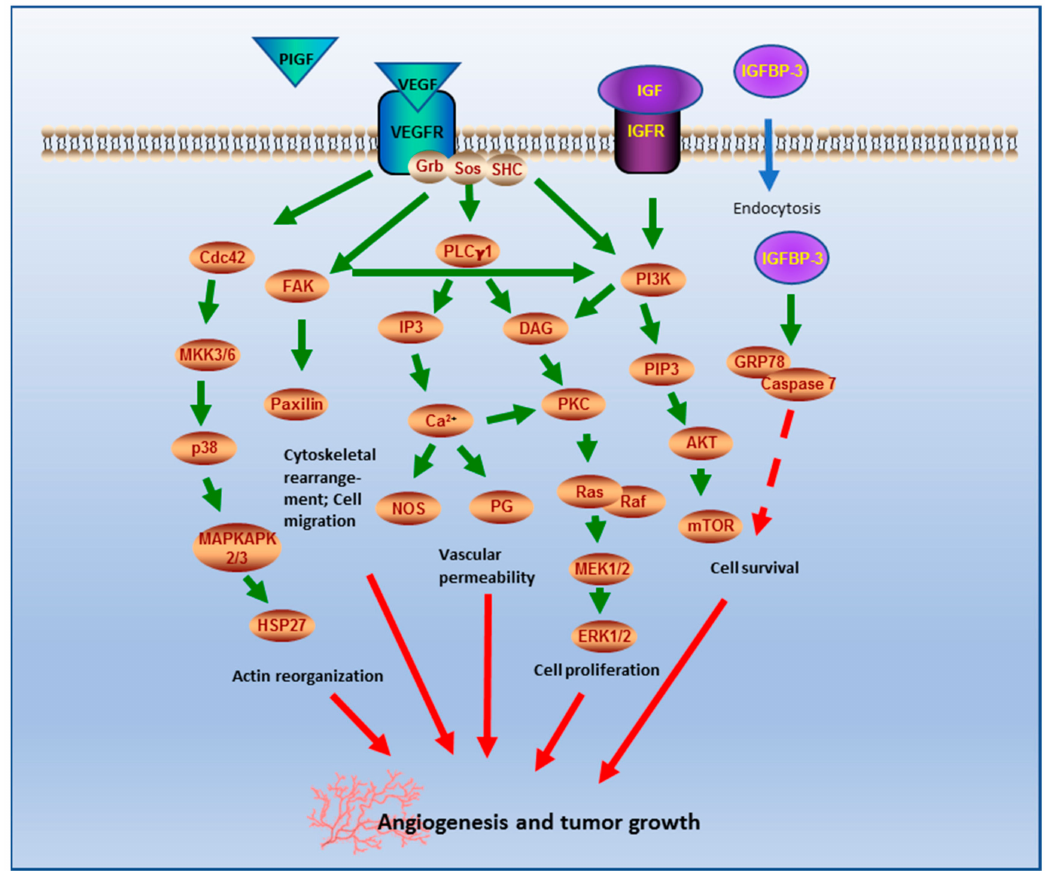
Figure 5. Simplified scheme of putative role, function, and involvement of VEGF, PlGF, and IGFBP-3 in signaling pathways described in angiogenesis and tumor growth. The downstream signaling pathway of the VEGF receptor (VEGFR), including adaptor proteins son of sevenless (SOS), growth receptor bound (Grb) 2, and Src homology 2 domain, can be activated by the ligands VEGF and PlGF. The activation of the mitogen-activated protein kinase (MAPK) signaling pathway via cell division control protein 42 homologous (Cdc42), mitogen-activated protein kinase 3 / 6 (MKK3 / 6), p38 mitogen-activated protein kinase (p38 / MAPK), and MAP kinase-activated protein kinase 2 /